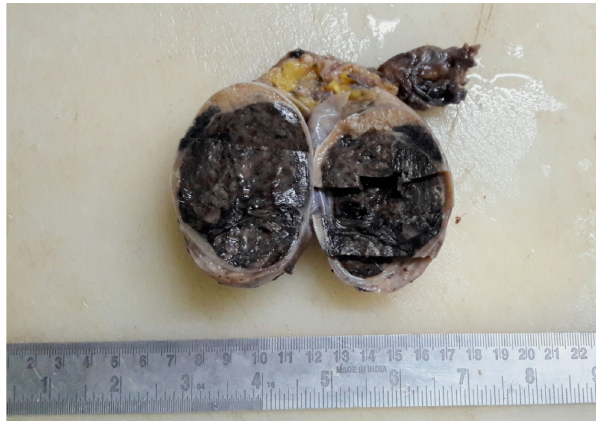
Figure 1: Orchidectomy specimen; Gross showing well capsulated solid mass with melanin pigments giving it a black homogenous appearance